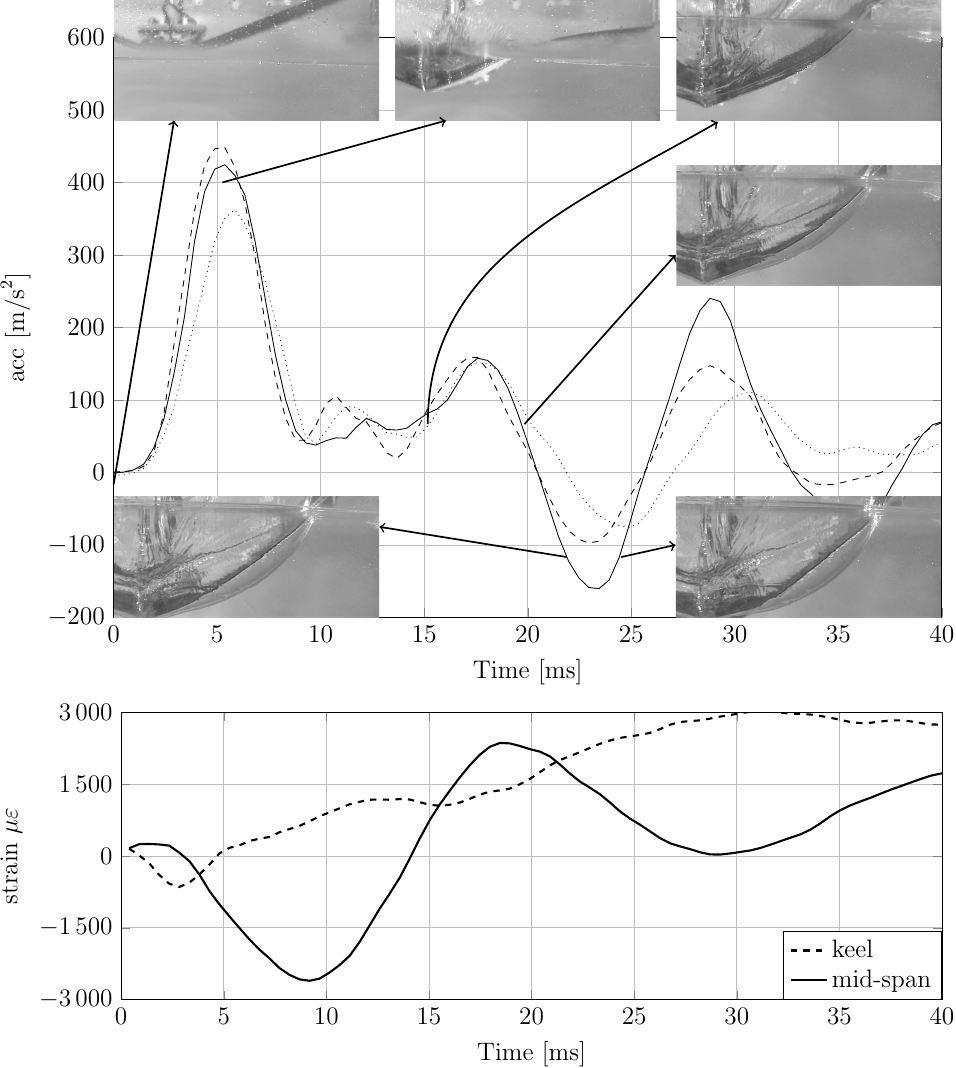
Figure 15. Graph of the recorded acceleration of a wedge ( V ) 2 mm thick ( β = 20 ◦ ) entering the water at 5.6 m/s, and high-speed camera images captured at 0, 5, 15, 20, 22.5, and 25